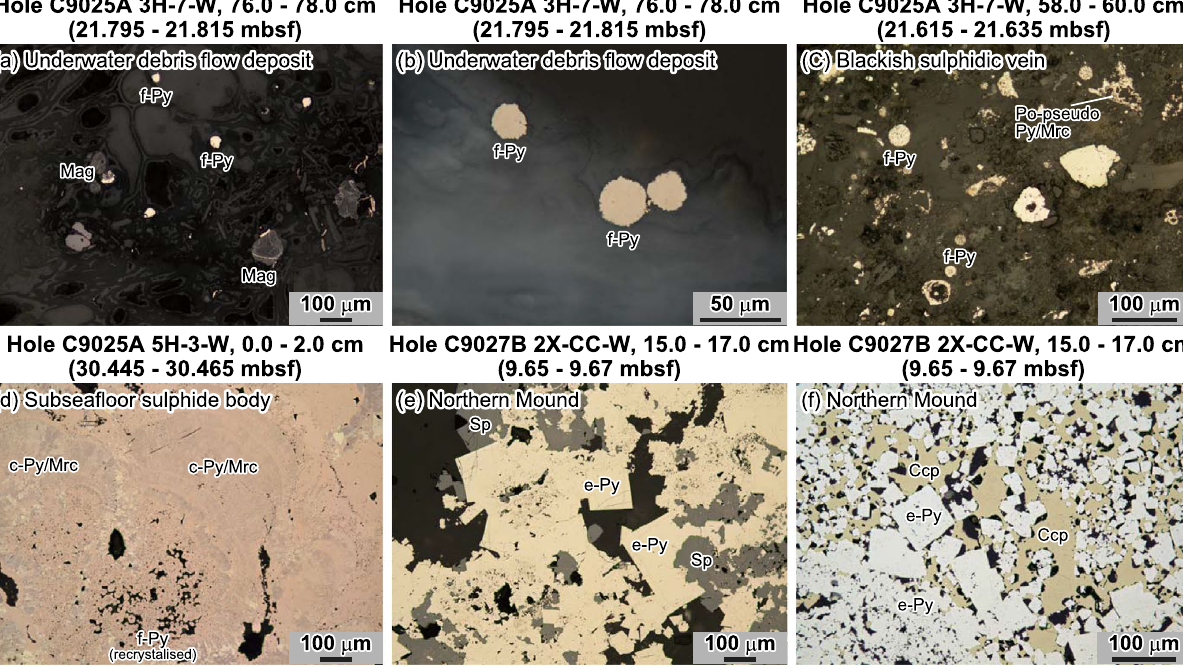
Figure 1. Microphotographs showing pyrite textures under reflected light. All images are in plane-polarised light unless otherwise noted. ( a , b ) Framboidal pyrite (f-Py) in pumice fragments of the hanging wall of the underwater debris flow deposit, ( c ) framboidal pyrite with pyrite/marcasite replacing pyrrhotite pseudomorphs (Po-pseudo) in the blackish sulphidic vein of the debris flow deposit, ( d ) colloform pyrite/marcasite (c-Py/Mrc) with recrystallised framboidal pyrite in the upper part of the subseafloor sulphide body (cross-polarised light), ( e , f ) euhedral pyrite (e-Py) with sphalerite or chalcopyrite in the sulphide body of the Northern Mound. Ccp chalcopyrite, Mag magnetite, Sp